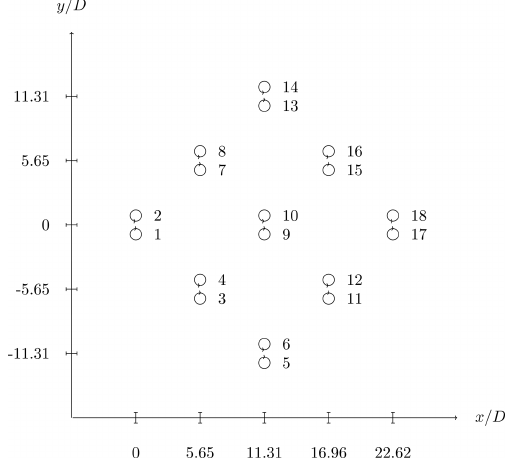
Figure 7. Fish schooling configuration. Turbines are placed in a counterclockwise-rotating fashion. The flow is also from left to right.